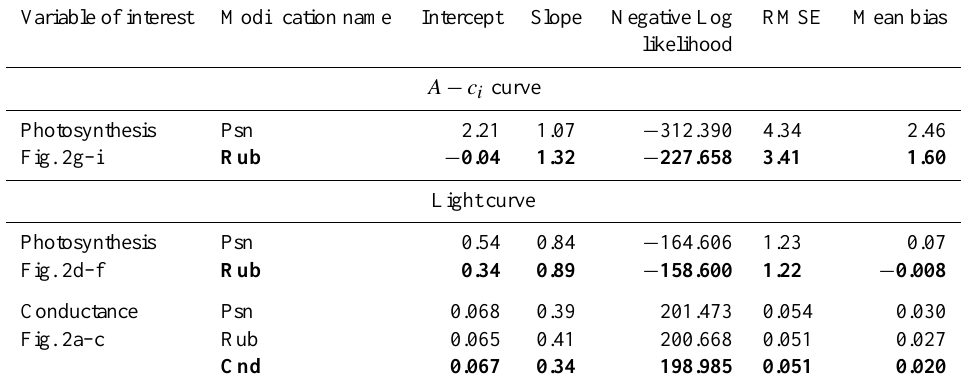
Table 2. Statistical results calculated for the Psn, Run, and Cnd modifications to the Farquhar/Ball-Berry model. Intercept, slope, negative log likelihood, root mean square error (RMSE), and mean bias were calculated for both conductance and photosynthetic responses to varying levels of light (light curve) and photosynthetic responses to varying levels of CO 2 ( A − c i curve) compared to observed tulip poplar responses at O 3 uptake values of 0, 2, and 4.2mmolm − 2 . Values in bold are the modifications within the response variable selected for use in the CLM simulations and are based on lowest negative log likelihood